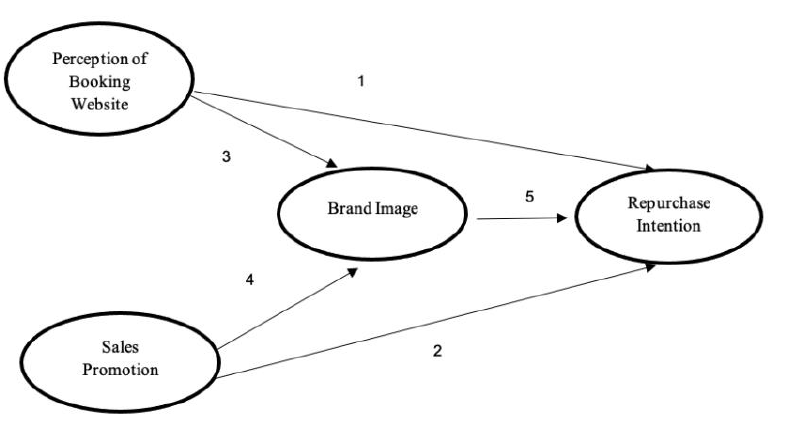
Figure 1: Conceptual Model of the Study, Source: Authors